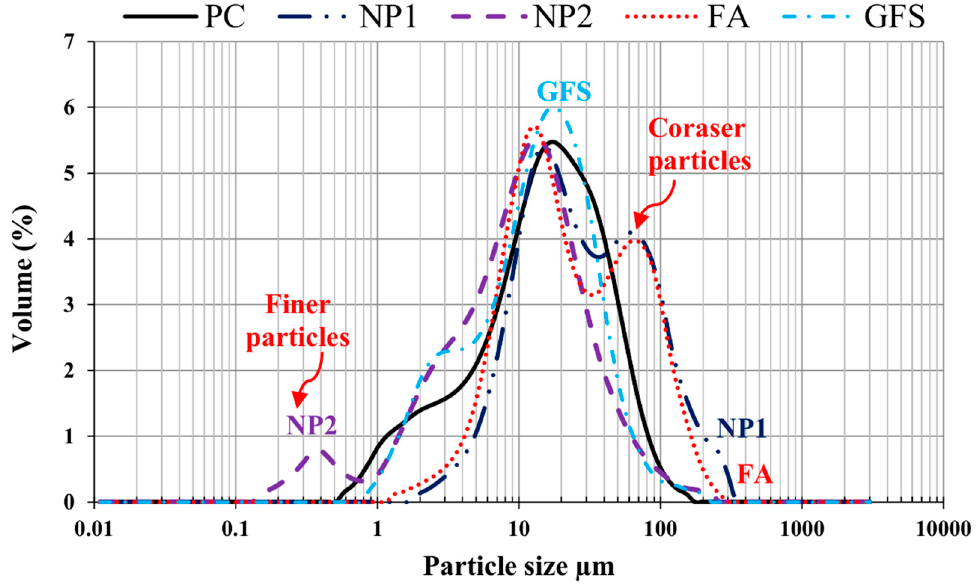
Figure 4. Volume ‐ based particle ‐ size distribution curves of PC, NP1, NP2, FA, and GSF. Figure 4. Volume-based particle-size distribution curves of PC, NP1, NP2, FA, and GSF. The particle-size distribution analysis shows that NP1 is coarser than NP2 and other powders. NP2 and FA have similar particle distributions. The median particle diameters of PC, NP1, NP2, FA, and GFS are 14, 18, 12, 20, and 13 µ m, respectively. The